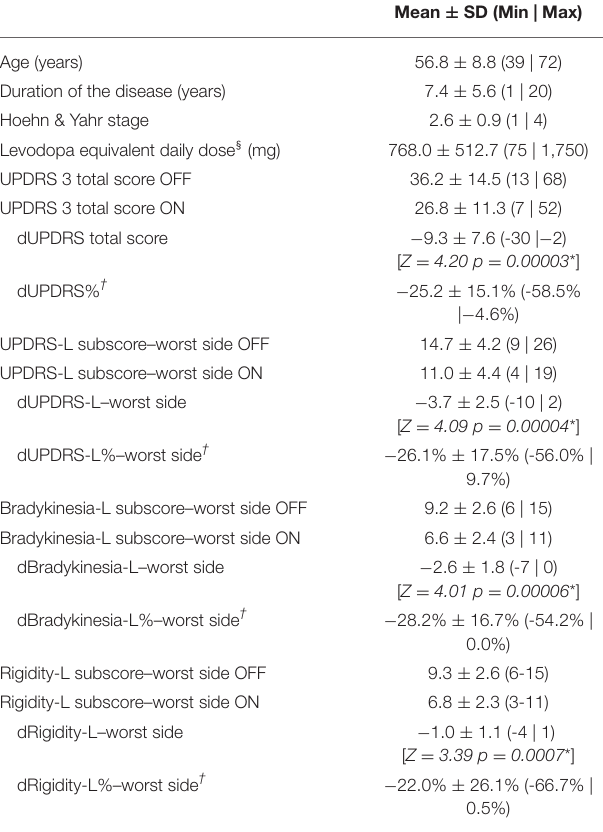
TABLE 1 | Clinical characteristics of the studied patients with UPDRS score and lateralized subscores off-medication and on-medication and the (sub) scores’ absolute and relative